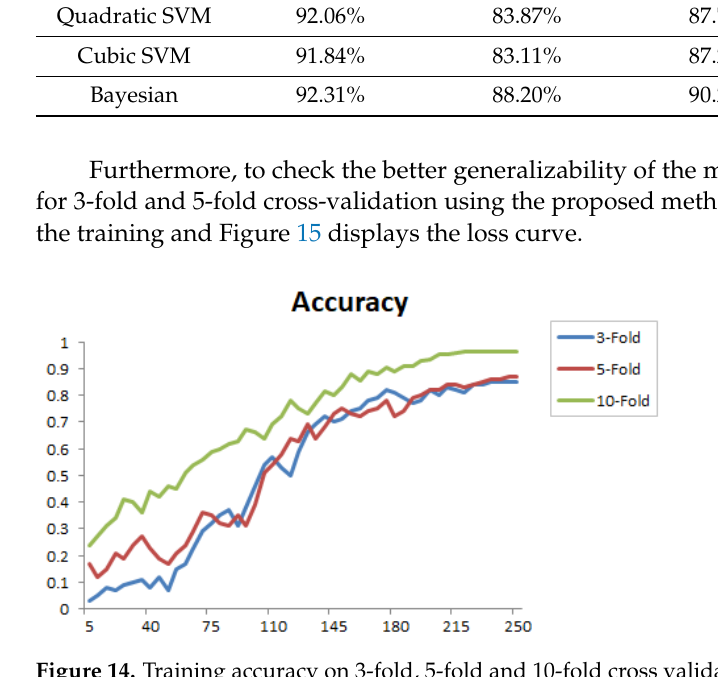
Figure 15. Training loss on 3 - fold, 5 - fold and 10 - fold cross validation. Finally, a comparison with existing GI tract disease classification techniques is pre- sented in Table 9. It can be observed that the proposed technique outperforms the